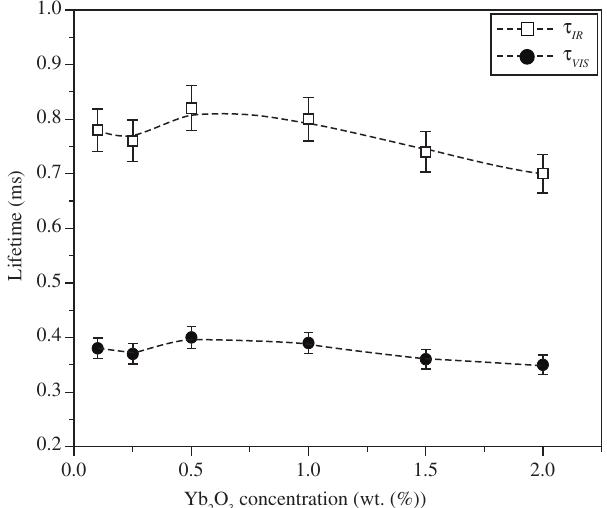
Figure 5. Cooperative ( τ GP